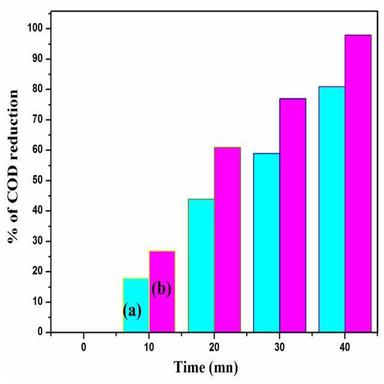
COD analysis of (a) SnO2 and (b) CdO-SnO2 nanocomposite material.